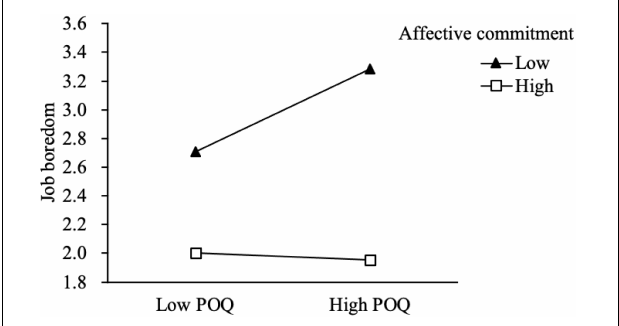
FIGURE 2 | Moderating effect of affective commitment on the relationship between perceived overqualification (POQ) and job boredom.